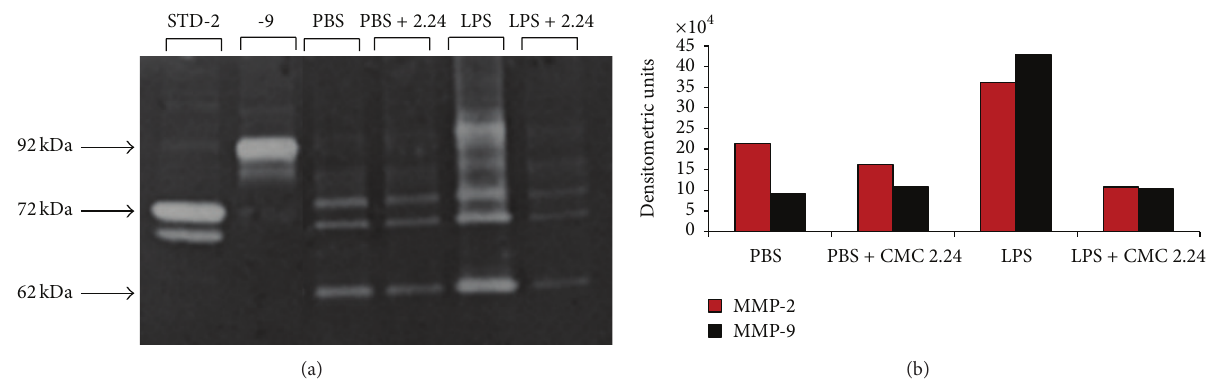
Figure 2: (a) Gelatin zymography of partially purified extract of gingiva from each experimental group showing the effect of orally administered CMC 2.24 on gingival MMPs (-2, -9). In groups 1 and 3, all rats received PBS injections into the gingiva plus oral administration of either vehicle alone (group 1) or CMC 2.24 (group 3). In groups 2 and 4, all rats received LPS injections into the gingiva plus oral administration of either vehicle alone (group 2) or CMC 2.24 (group 4). (b) Densitometric analysis of gingival MMPs (-2,